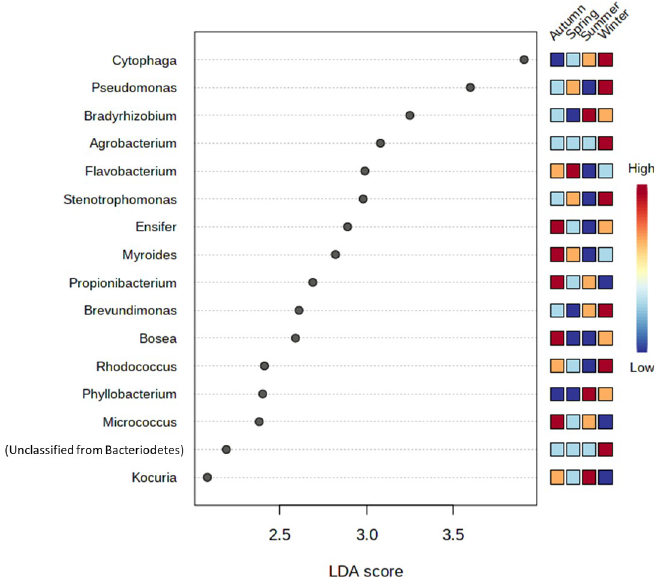
followed by Moraxella (RA-12.5%) and, Staphylococcus (3%). Flavobacterium , Myroides , Pseu- domonas and Finegoldia although always detected, had widely varying RA. Apart from these, there were a good number of other genera (RA) � 1% that are also supposed to be contributors to the overall seasonal variations (Fig 4). According to the R analysis, the genera distribution was never the same in any of the seasons. The top 25 were plotted on bar graphs (Fig 5A–5D). It is quite evident that seven prevalent gen- era were repetitively detected in all four seasons. Among these, Staphylococcus showed maxi- mum MD in autumn, spring and winter followed by Corynebacterium and Moraxella . Apart from this key indicator genera for autumn were Bosea , Myroides Ensifer and Paenibacillus with an abundance � 95%. In winter, Cytophaga , Agrobacterium , and Rhizobium existed in 95% of